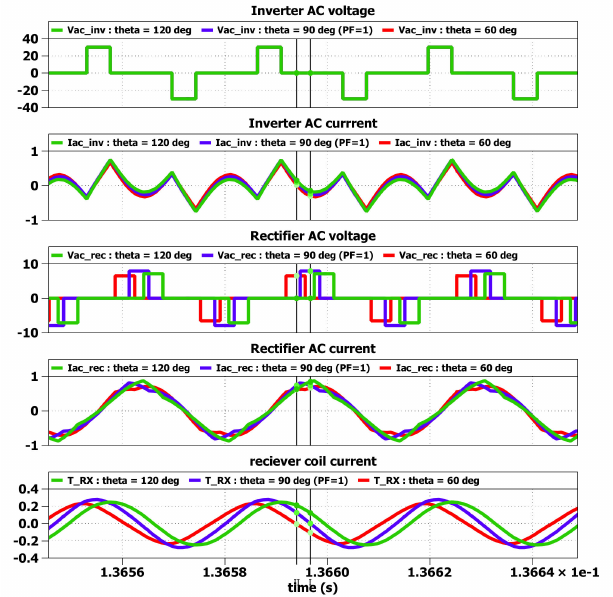
Figure 31. DAB smooth startup transition stage (2): rectifier δ (deg) auto-adjustment to achieve unity power factor control of rectifier DAB